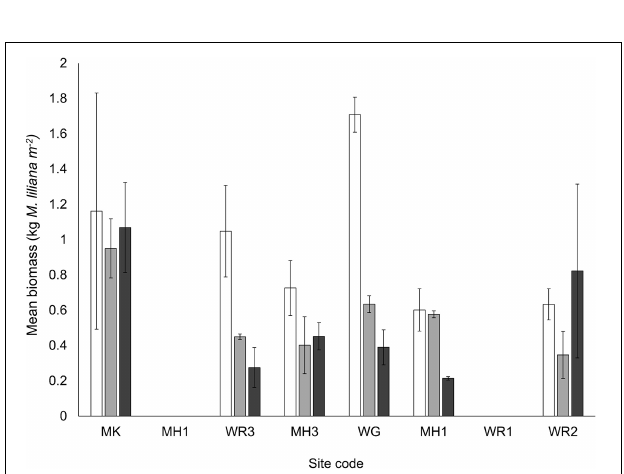
FIGURE 7 | Relationship between the water clarity and the mean proportion of bacteria-associated FAs (C15:0 + C17:0) in the sediment across ambient nitrogen conditions (control plots) in all sites. ( r 2 = 0.67).